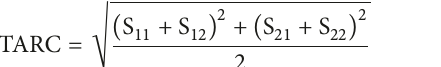
2X2 MIMO antenna system TARC can be calculated by the following relations